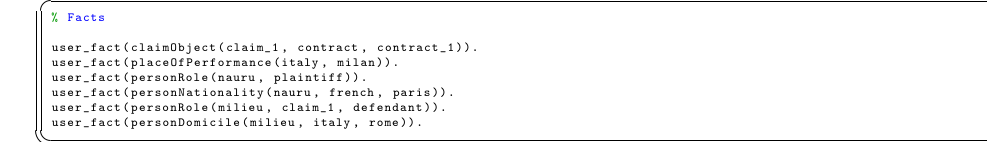
Figure 13. Facts Prolog